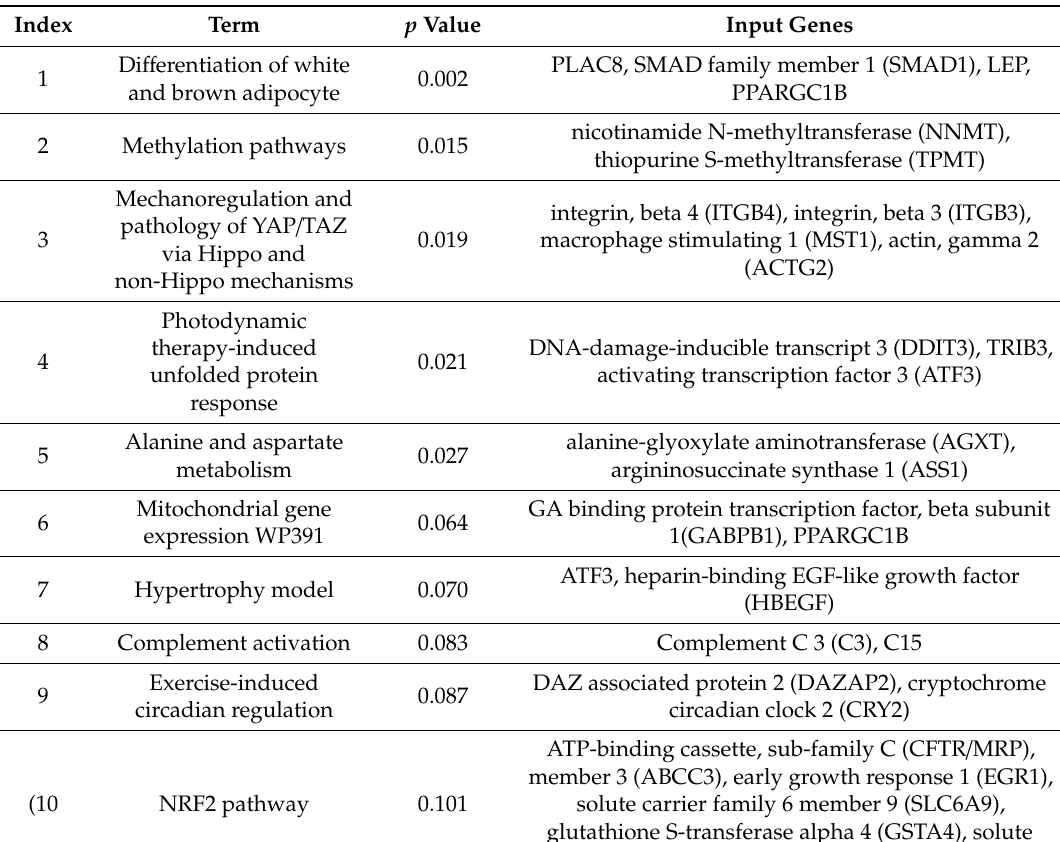
Table 3. Top 10 significant biological pathways associated with di ff erentially expressed genes after 10 nM bisphenol A (BPA) treatment of BeWo cells using the WikiPathways 2019 Human database (Enrichr). The most significantly regulated pathway is di ff erentiation of white and brown